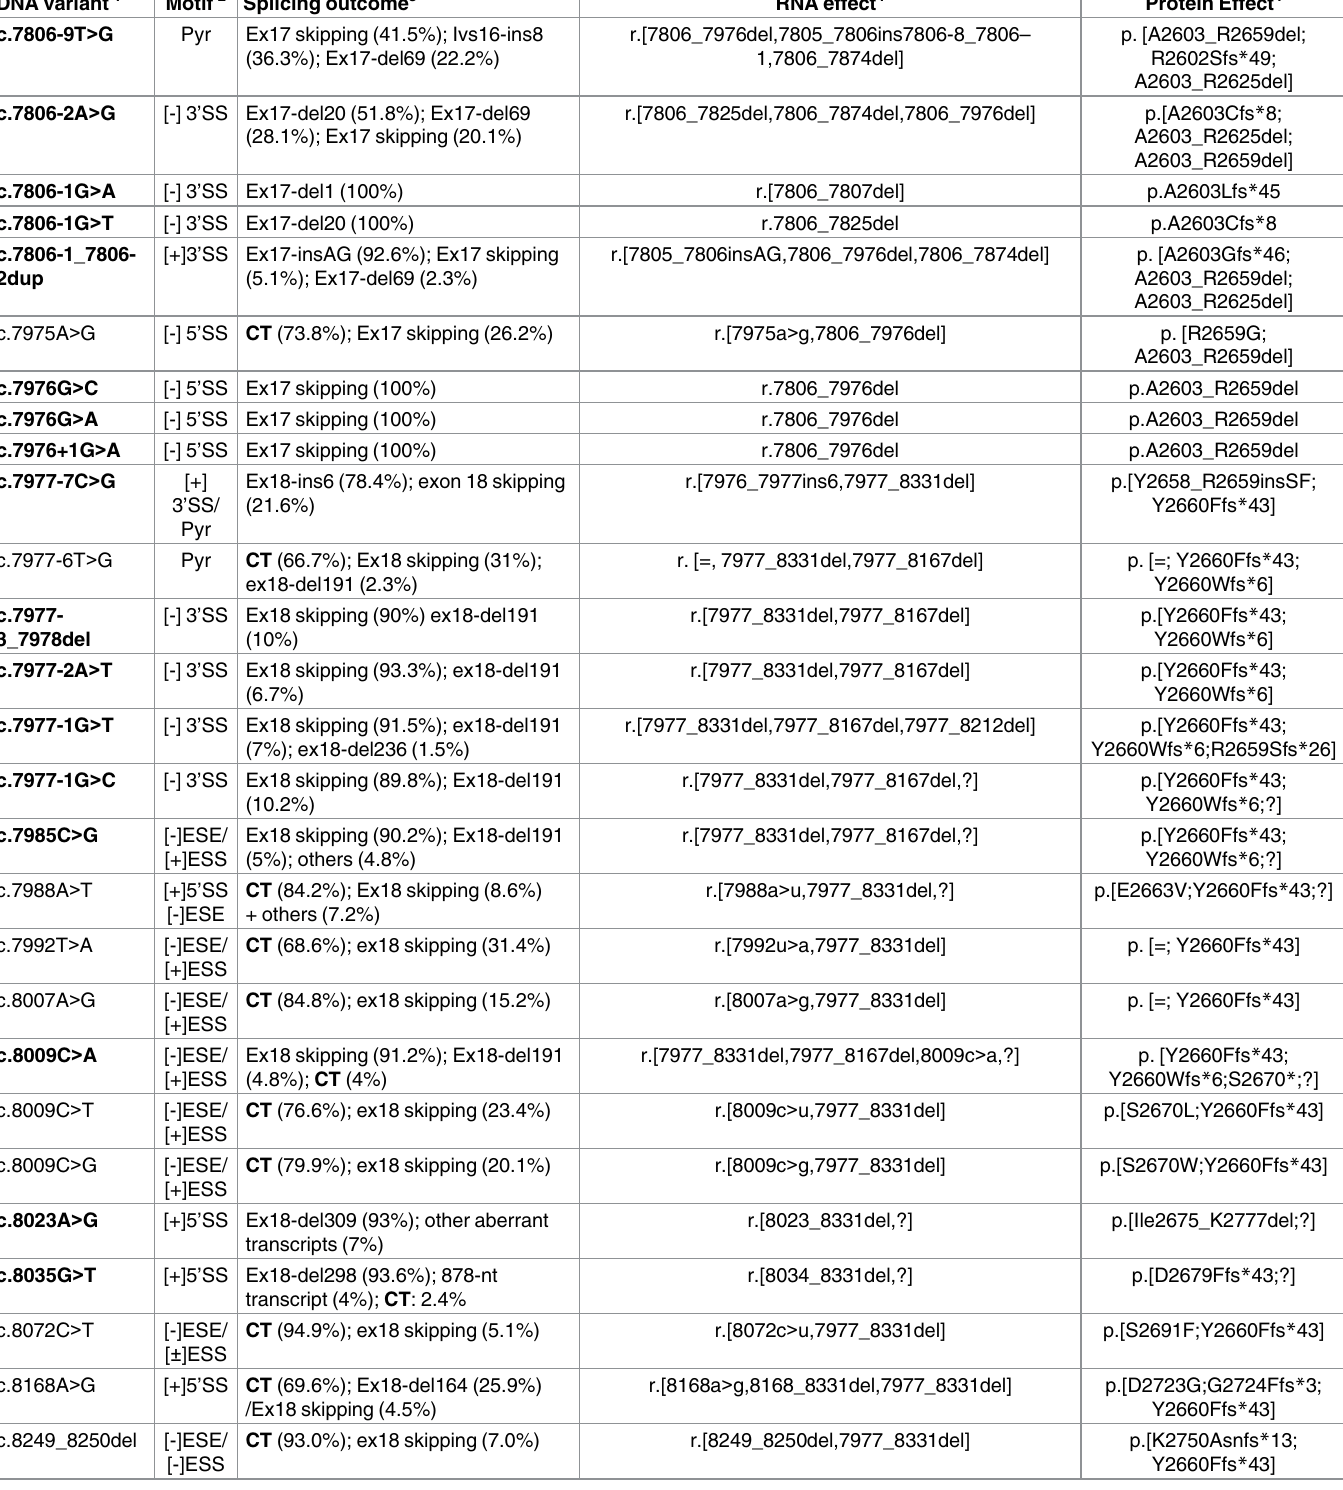
Table 1. Splicing outcomes of BRCA2 exons 17 and 18